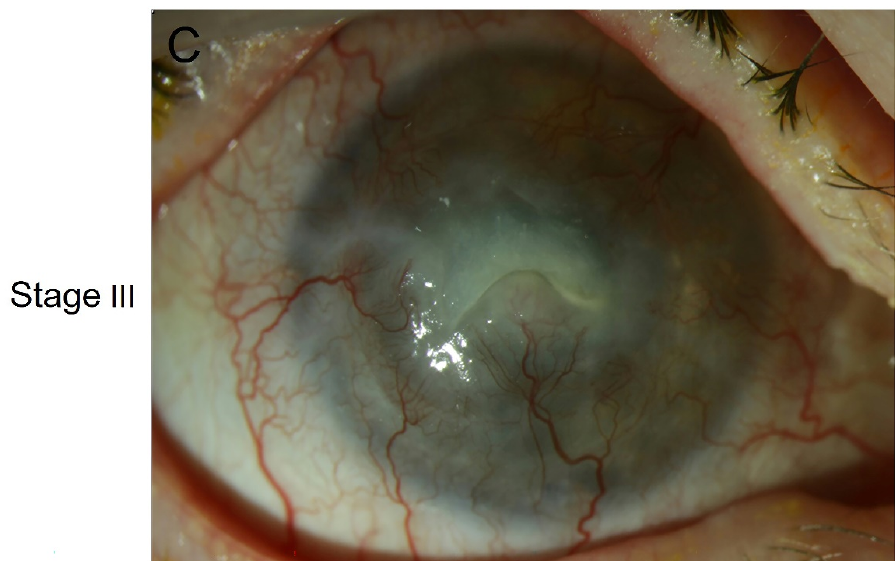
Figure 3. Slit-lamp photographs of eyes with stage I, stage II, and stage III of LSCD, respectively. ( A ) Corneal opacity and corneal pannus not extending to the central 5 mm zone of the cornea with less than 50% of limbal involvement. At the 4 to 6 o’clock positions, conjunctival vessels are growing onto the peripheral cornea, which corresponds to stage I LSCD. ( B ) Corneal opacity affecting the central 5 mm zone of the cornea with less than 50% of limbal involvement corresponding to stage II LSCD. ( C ) Conjunctival growth on the cornea is seen at each limbus position, and the entire cornea is vascularized and opacified. Moreover, a central epithelial defect is seen. This example corresponds to stage III LSCD [171]. Abbreviations: LSCD: limbal stem cell